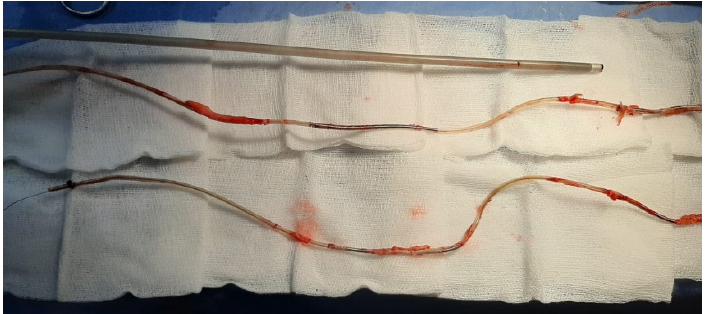
Figure 3. Extracted leads with extensive fibrosis.